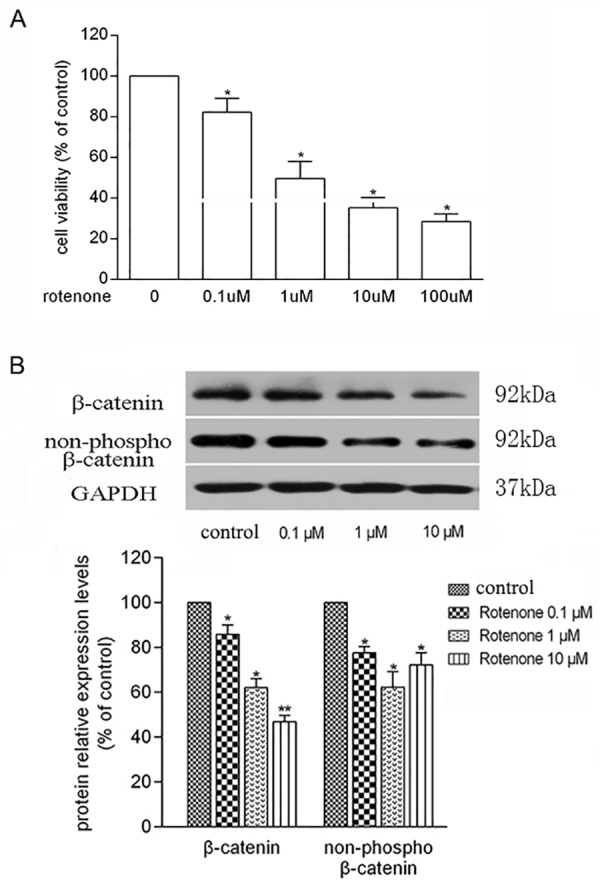
Rotenone affected the cell viability and Wnt/β-catenin of PC12 cells.A. cells were treated with 0~100 μmol/L (μM) rotenone for 24 hours. Cell viability was measured as percentage relative to vehicle (*P < 0.05; **P < 0.01). B. Rotenone deregulated Wnt3a, β-catenin, and non-phospho β-catenin in a concentration-dependent manner. The relative intensity of protein band was normalized to GAPDH by Image J software (*P < 0.05; **P < 0.01). All data presented as means ± SD from three independent experiments.